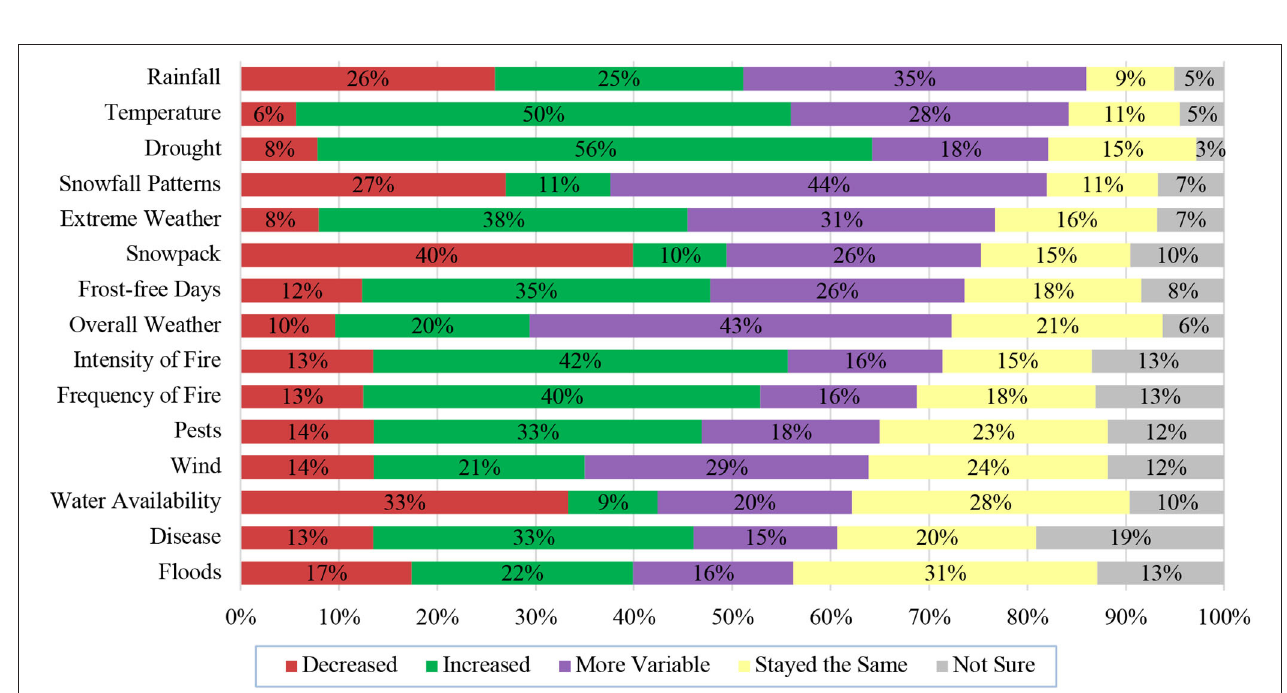
FIGURE 5 | Observations and perceptions on environmental change. Percentage of informants that reported they perceived a decrease, increase, variability, no change, or were not sure of change in environmental factors.